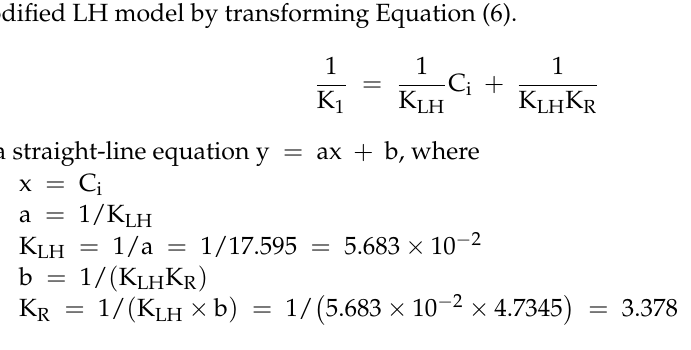
Table 1. Rate constants of reactions of MB photodegradation at various MB concentrations, reaction temperatures, light intensities, and NiTiO 3 /TiO 2 -decorated CNFs catalyst